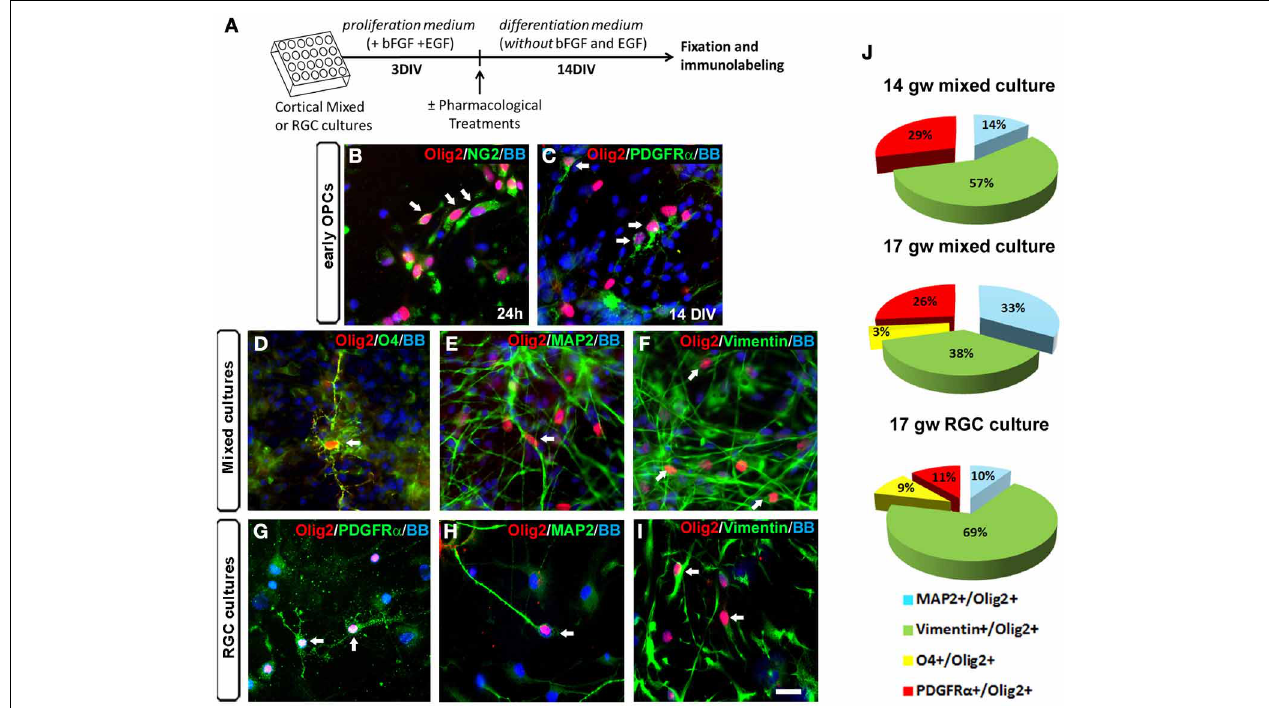
FIGURE 2 | Olig2 expression in human mixed and radial glia cell (RGC) cultures. (A) Time-line of the cell cultures protocol used. (B–I) Olig2 (red) expression in mixed cell cultures in NG2 + cells at 24h (B) and in PDGFR α + early OPCs at 14DIV (C) . Olig2 expression in mixed cell cultures at 14DIV was observed in O4 + late OPCs (D) , in MAP2 + neurons ( E ) and in vimentin +